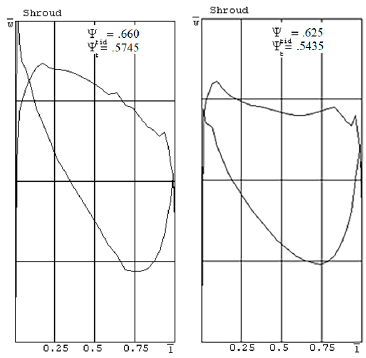
Figure 4. 3DM.023 program. Velocity diagrams on the shroud streamline in the impeller of the TKR 140E compressor. Left: according to the preliminary design. Right: after optimizing the impeller sizes and blade shape. w = w/u 2 —relative velocity, l = l/l 1 − 2 —relative